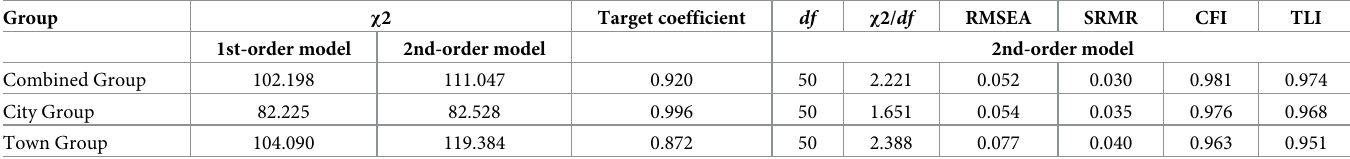
Table 3. Measurement model indices for PA construct.